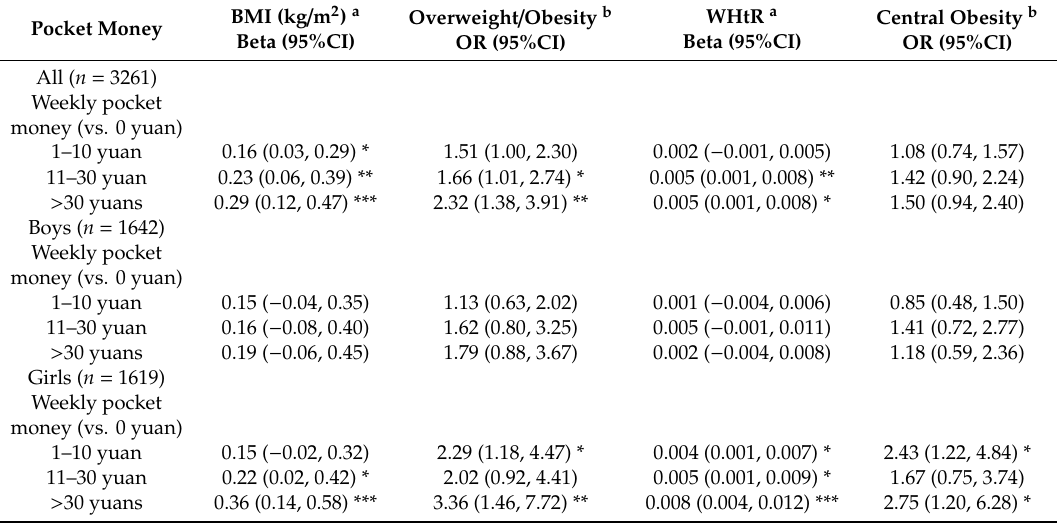
Table 4. Longitudinal associations between children’s pocket money and their body weight status: The Childhood Obesity Study in China Mega-Cities,